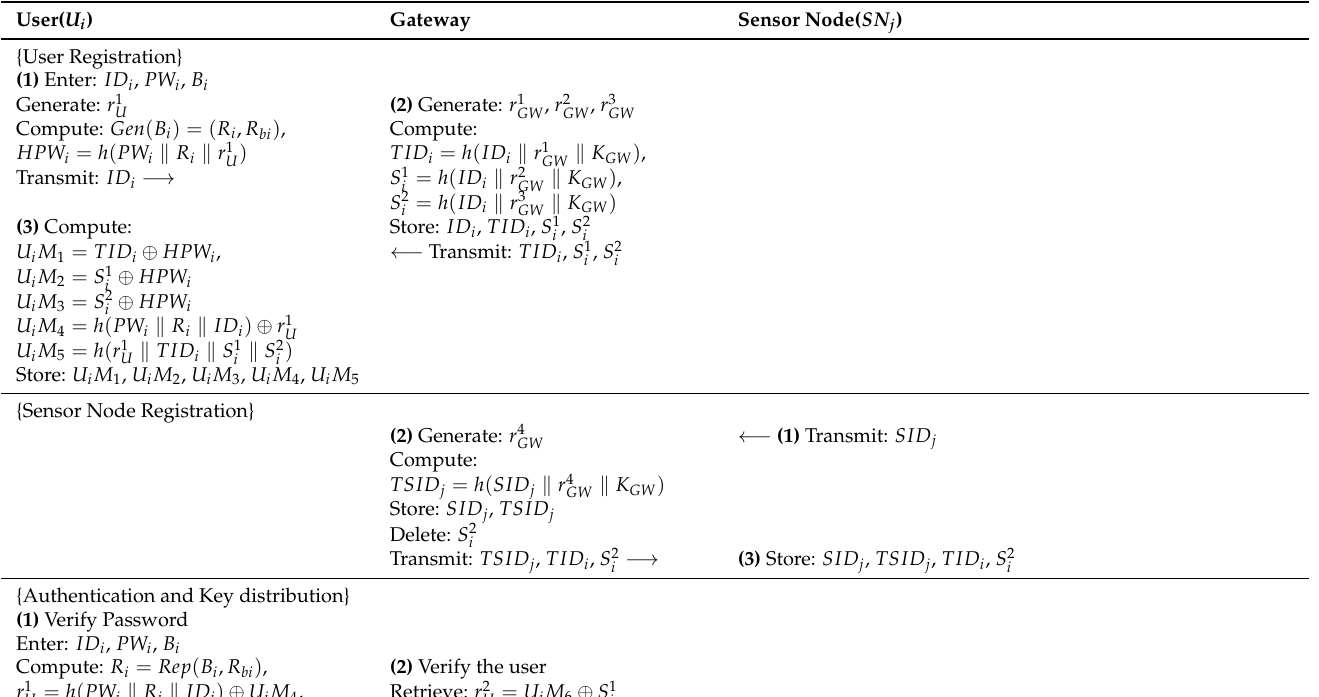
Table 4. The proposed